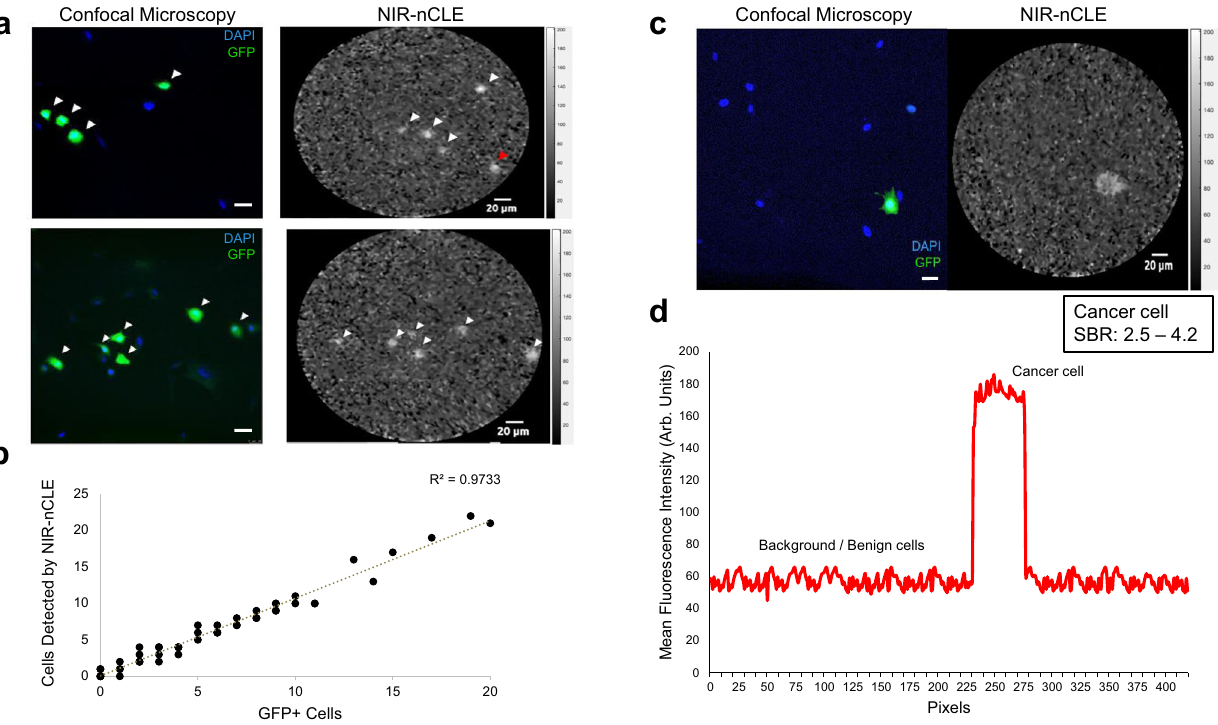
Fig. 2 NIR-nCLE discriminates malignant cells from normal cells in culture. a Paired confocal microscopy and NIR-nCLE images of GFP-transfected lung adenocarcinoma (A549-GFP) cells co-cultured with normal lung fi broblast (HD28) cells. White arrowheads indicate NIR-nCLE fl uorescence concordant with confocal microscopy at GFP wavelength and red arrowheads indicate discordant fl uorescence. Scale bars represent 20 µ m. b Correlation of the number of cancer cells detected by NIR-nCLE in individual still images and compared to the number detected by paired confocal microscopy images at GFP wavelength as the gold standard. c Detection of a single malignant cell by NIR-nCLE when A549-GFP and HD28 cells were co-cultured at a ratio of 1:1,000. Scale bars represent 20 µ m. d Fluorescence intensity cross-sectional pro fi le of a NIR-nCLE image of a single malignant cell, illustrating the high SBR (range 2.5 – 4.2) of cancer cells in culture imaged by